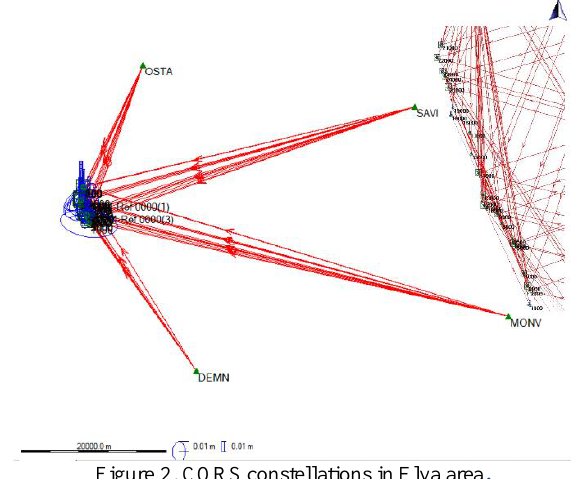
Figure 2. CORS constellations in Elva area .